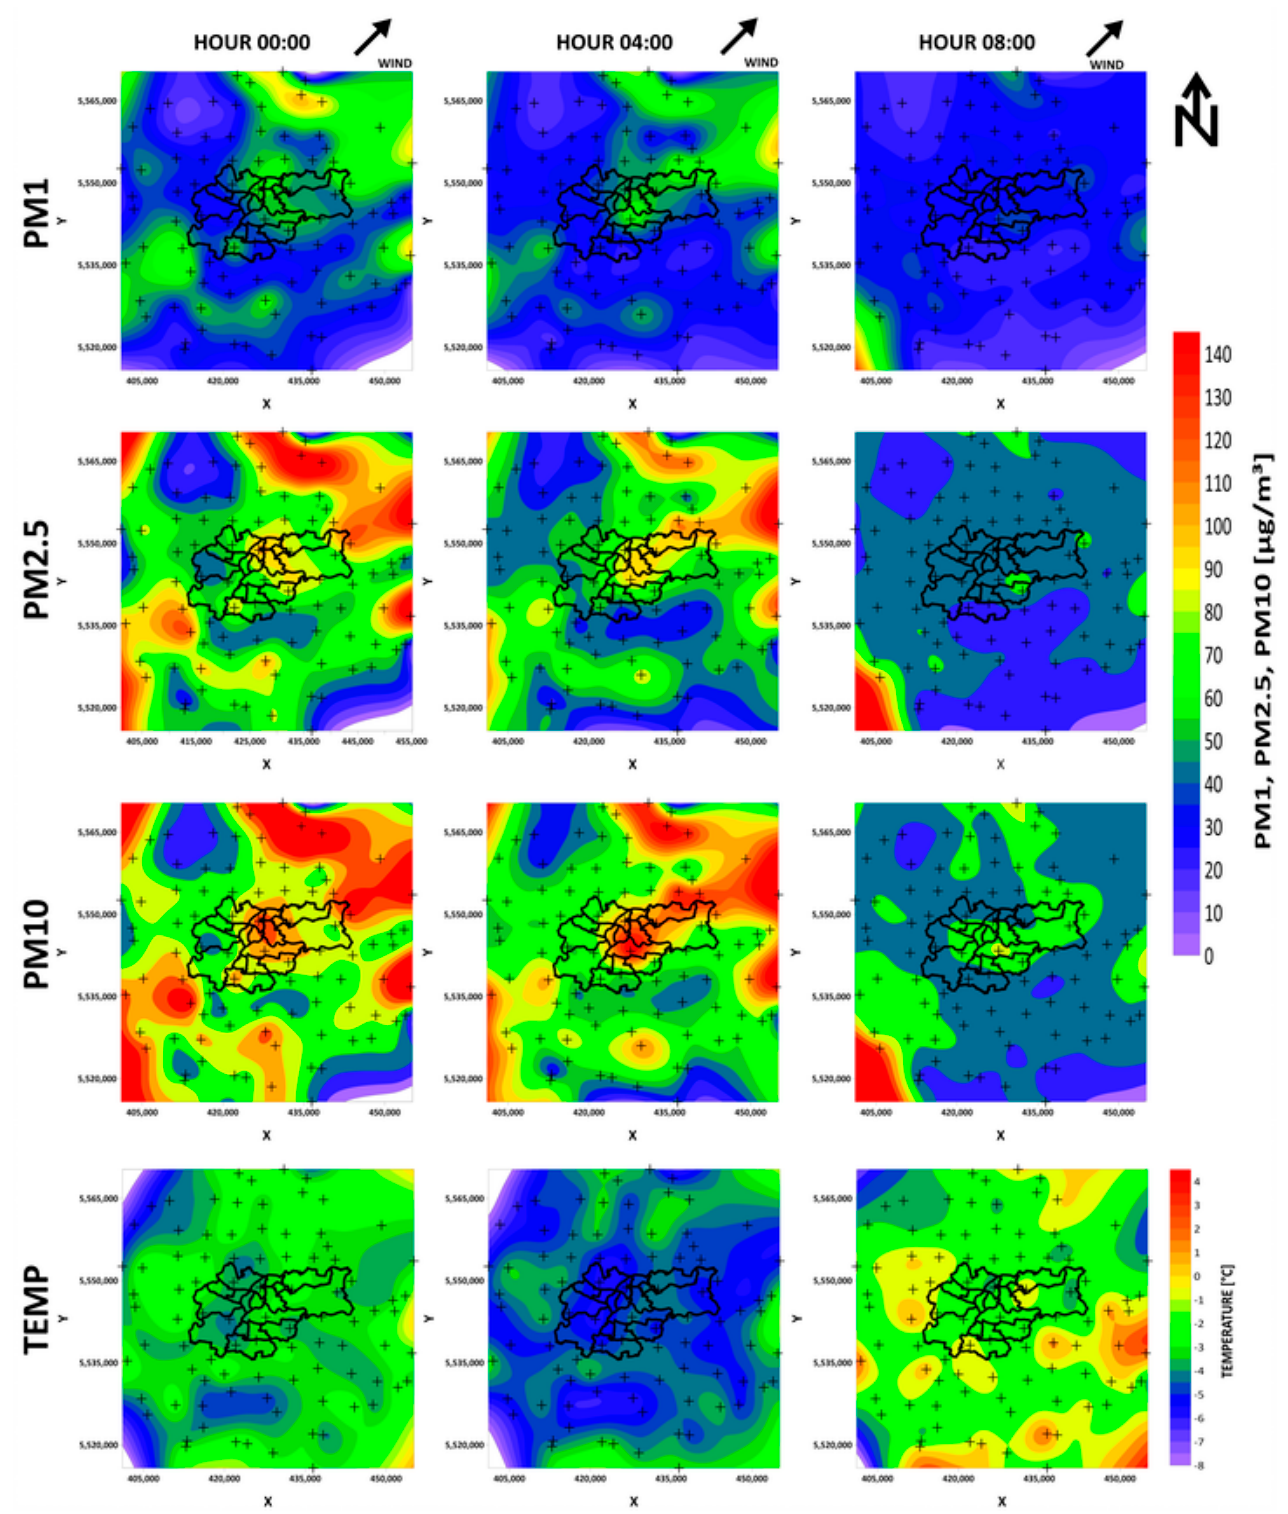
Figure 7. Temperature maps of air pollution leaving (PM1, PM2.5, PM10) Krakow on 11 March 2020.